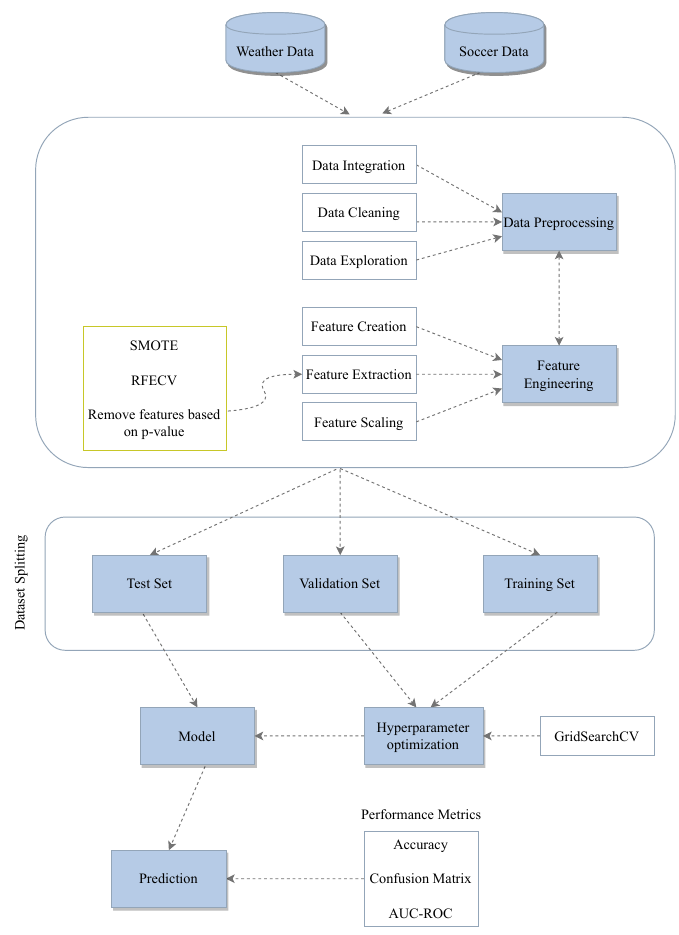
Figure 1. Flowchart of the proposed